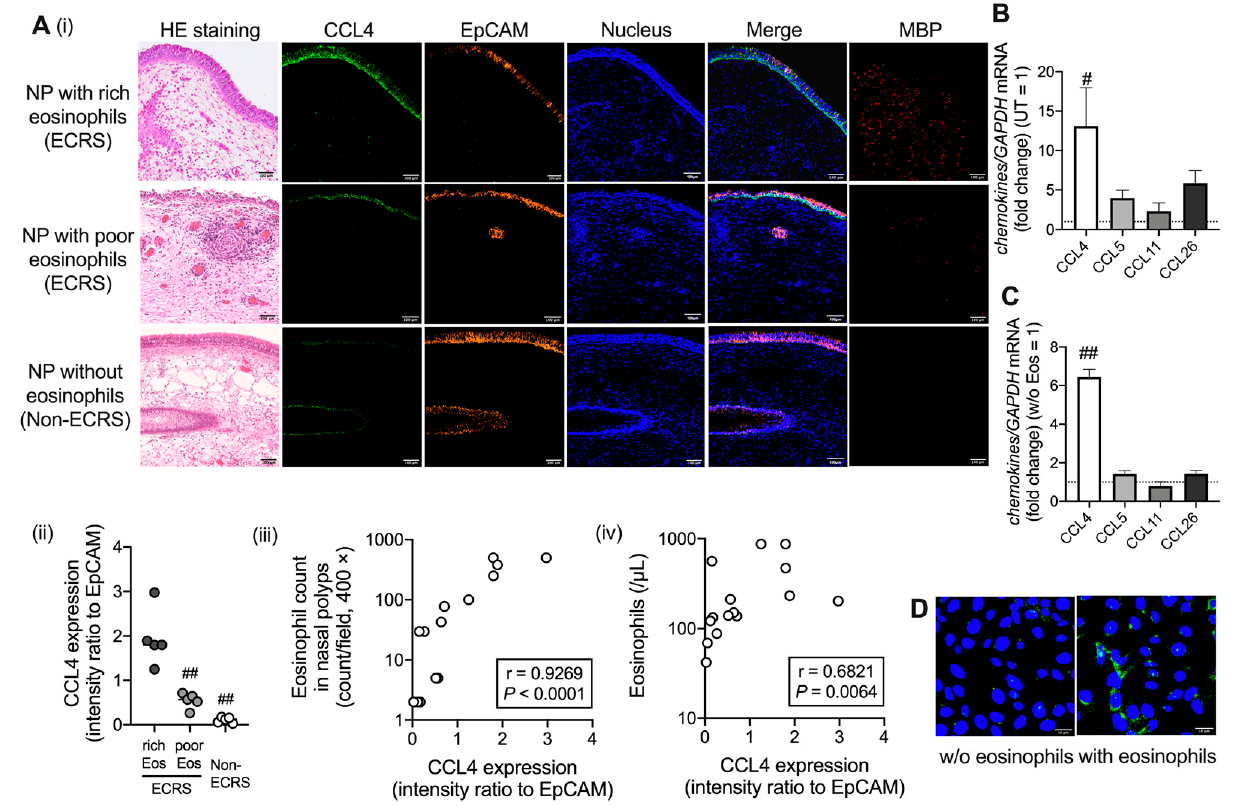
Figure 1. CCL4 expression in airway epithelial cells. ( A ) Immunofluorescence analysis of nasal polyps (NP) with rich eosinophils (Eos) (n = 5) or poor Eos (n = 5), or without Eos (n = 5). CCL4 and EpCAM expression levels were measured. CCL4 (green), EpCAM (orange), MBP (red), and the nucleus (blue) are stained with hematoxylin and eosin (HE) (i). Images were obtained using an FV3000 confocal microscope (100 × objectives). The scale bars in the bottom-right corner indicate 100 µ m. CCL4 intensity is expressed as a fold change relative to EpCAM (ii). The correlation of CCL4 expression with eosinophil count in NPs (iii) and Eos from the peripheral blood (iv). ( B ) CCL4 , CCL5 , CCL11 , and CCL26 mRNA levels were determined in NPs and uncinate process tissues (UTs) obtained from patients with ECRS. ( C , D ) CCL4 expression in BEAS-2B cells co-cultured with purified Eos (from peripheral blood) overnight. CCL4 , CCL5 , CCL11 , and CCL26 mRNA levels were determined ( C ). Images (CCL4, green; nucleus, blue) were obtained using an FV3000 confocal microscopes (200 × objectives) ( D ). Scale bars in the bottom-right corner indicate 10 µ m. The values in B and C represent the mean ± SEM of four experiments. # p < 0.05, ## p < 0.01 (vs. NPs with rich Eos in A, UTs from the same patients in B, and NPs without Eos in C).